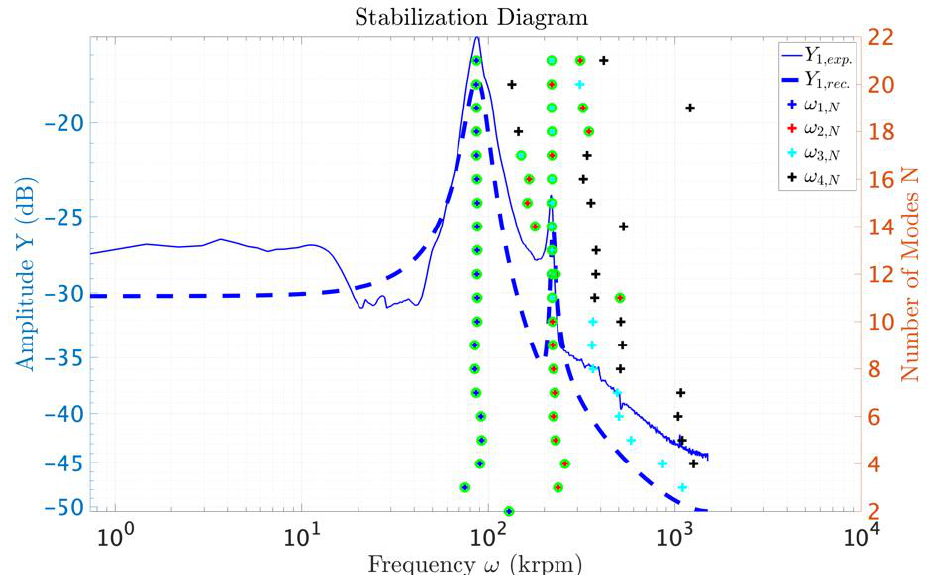
Figure 5. The experimental and reconstructed spectra at 0.5 MPa supply pressure.